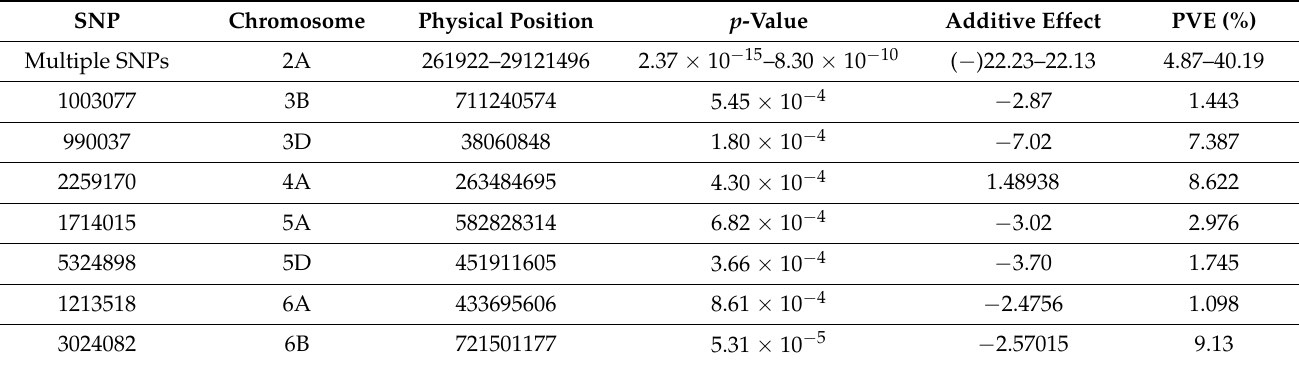
Table 1. Significant SNPs associated with WB